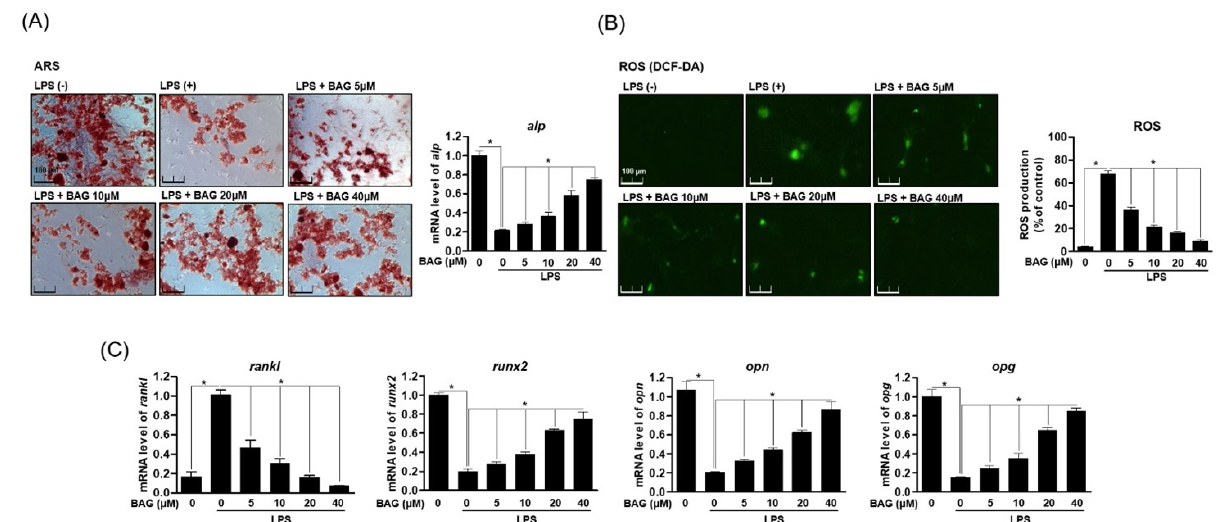
Figure 7. BAG induces bone formation through inhibition of LPS-induced ROS and up-expression of osteoblast-specific genes. ( A ) MC3T3-E1 cells were cultured for 14 days with a medium containing 50 µ g/mL ascorbic acid and 20 mM β -glycerophosphate and simultaneously treated with the indicated concentrations of BAG and LPS, followed by Alizarin red s staining. ( B ) Representative stain images of LPS-induced ROS generation were detected by using DCFH-DA in MC3T3-E1 cells with different indicated concentrations of BAG. ( C ) Osteoblast-specific gene expression was analyzed using real-time PCR, and the results were normalized to the expression of GAPDH. * p < 0.05, versus the RANKL treated